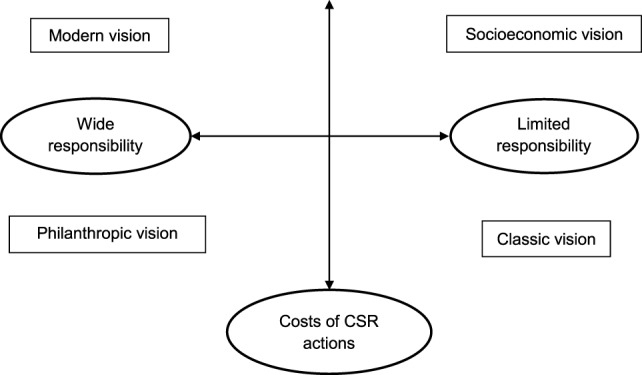
Two-dimension model of CSR (18).